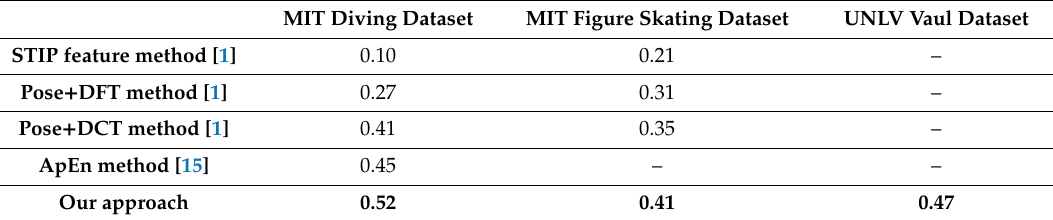
Table 4. Comparison results of the proposed method with the baseline and other relevant methods.